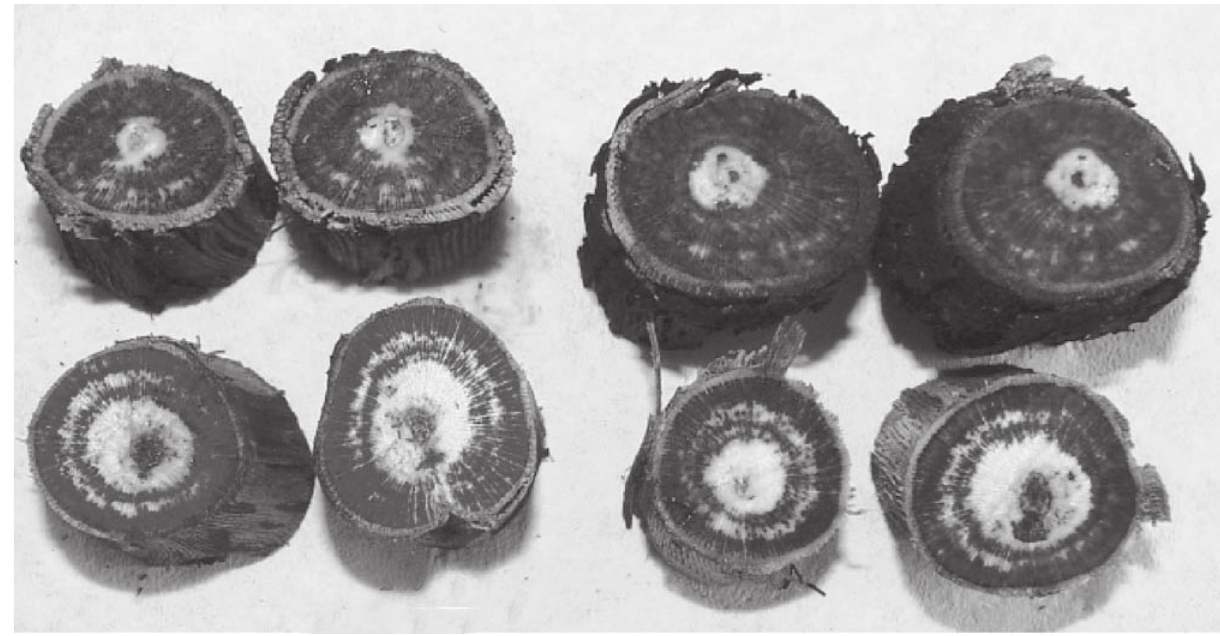
Fig. 1. Comparison of the functional xylem (blue coloured vessels) of two five-year-old Verdleho grapevines. Top, trunk of a grapevine with no black goo, 76% functional xylem. Bottom, trunk of a grapevine with 2% vessels blocked with black goo, 54% functional